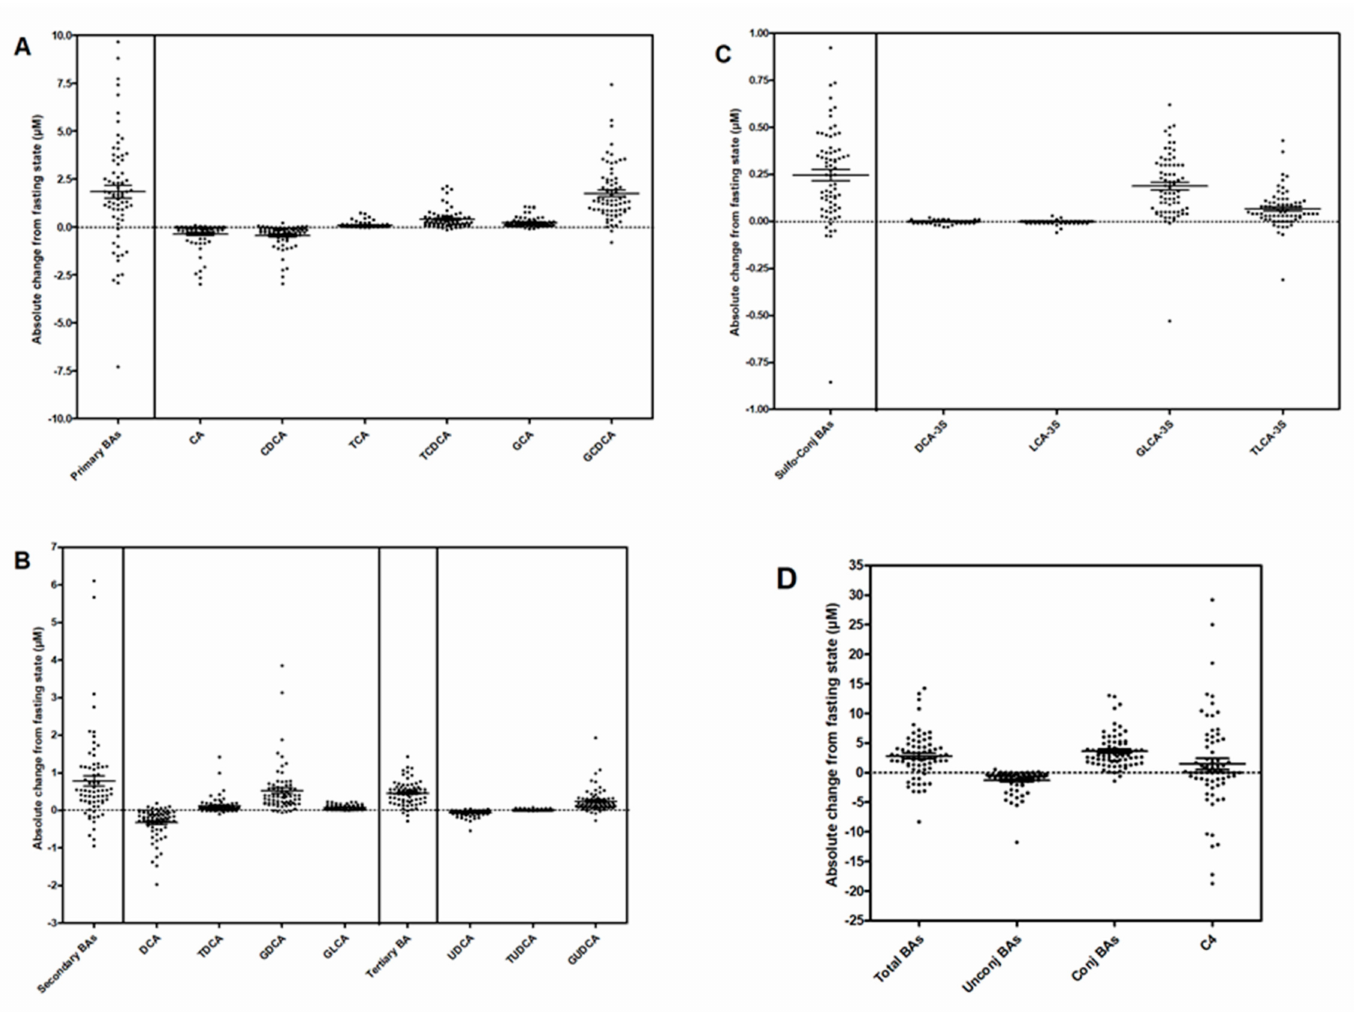
Figure 3. Interindividual variability of maximal absolute postprandial change from fasting sate in circulating BA levels. ( A ) Primary BAs. ( B ) Secondary and Tertiary BAs. ( C ) Sulfo-conjugated BAs. ( D ) Total BAs, unconjugated, conjugated BAs, and BA synthesis marker 7 α -hydroxy-4-cholesten-3-one,